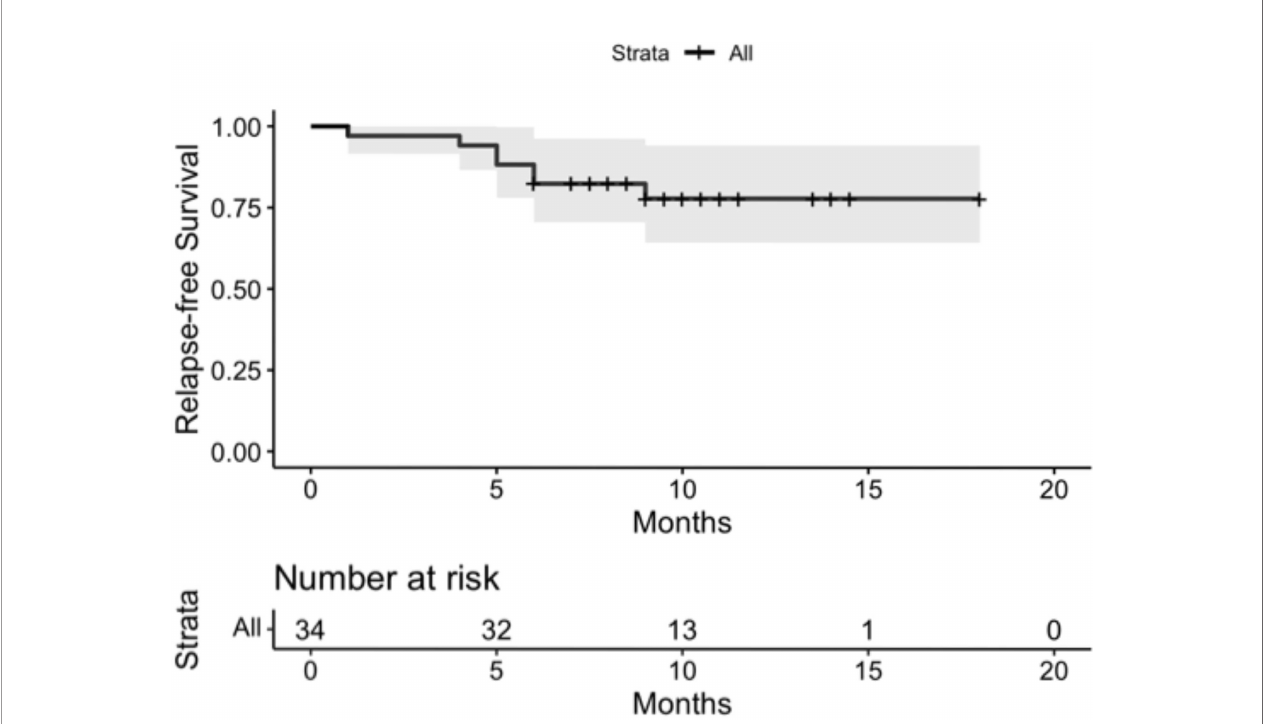
FIGURE 2 | For the entire cohort, the 1-year Relapse-free survival (RFS) was 77.8% (95% con fi dential interval (CI) 64.2% to